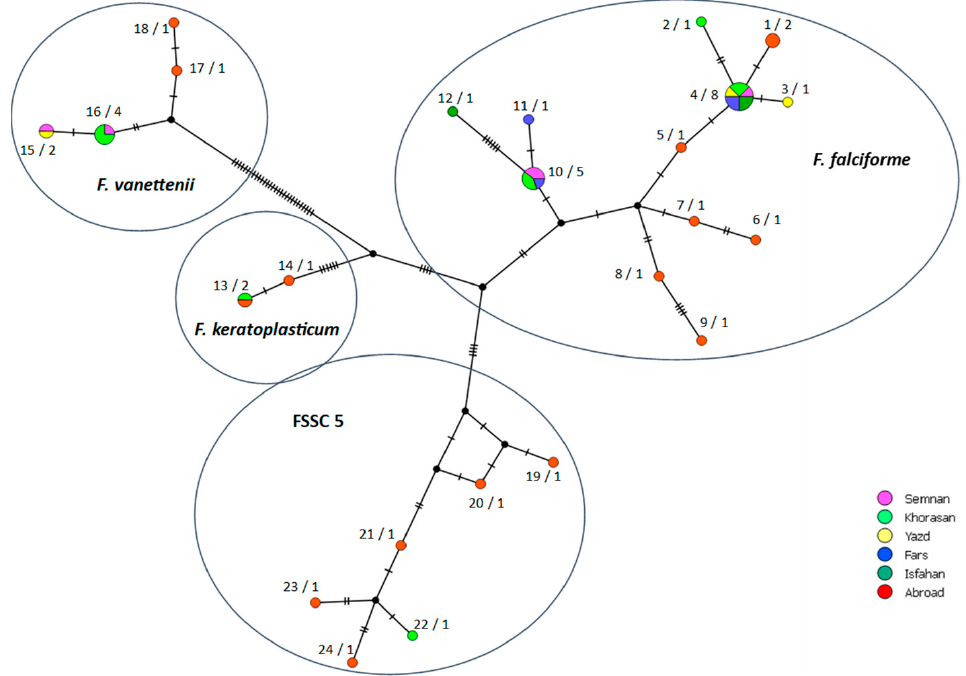
Figure 4. TCS multilocus haplotype network generated using the POPArt program by combining three gene regions (ITS, LSU, and tef1 ) of FSSC isolates recovered from melons in Iran. The size of the circles indicates the relative frequency of sequences of a given multilocus haplotype (MH). Hatch marks along the branches indicate the number of mutations. Each color represents one of the five provinces where the FSSC isolates were recovered. The isolates retrieved from GenBank and FS-Spa reference isolate received from Spain are assigned to the category ‘Abroad’. The numbers on the left of a slash indicates the MH number (Table 1), while the numbers on the right of the slash indicates the number of isolates in a given MH.